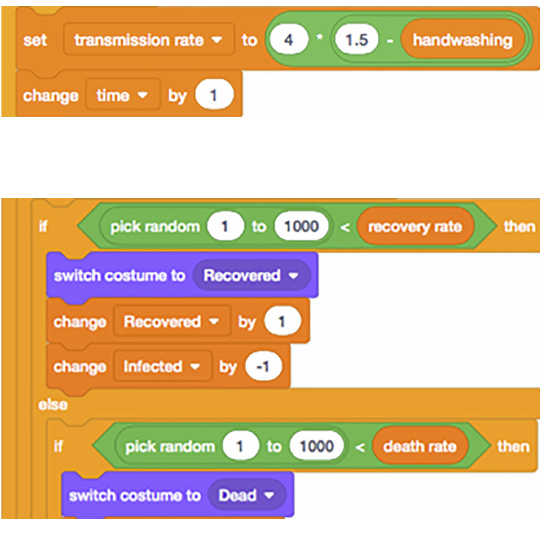
Figure 17. Coding blocks for the equation of the marker on the grapher in simulation 2